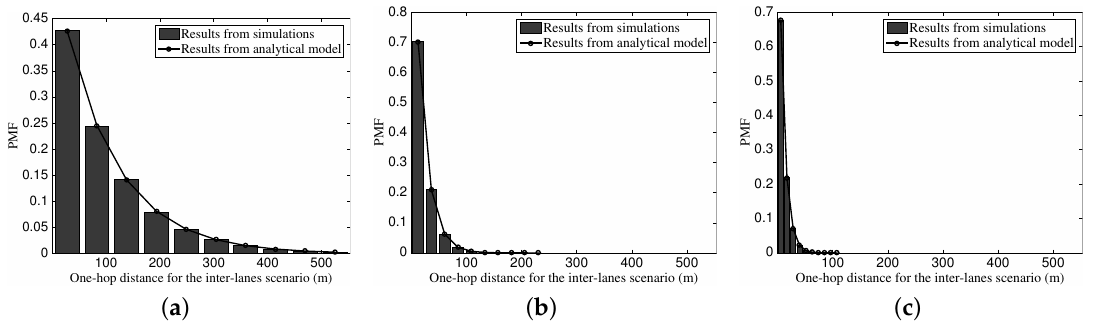
Figure 9. The PMF of one-hop transmission distance for the inter-lane scenario with different vehicular traffic density: ( a ) ρ 2 = 10 vehs/km; ( b ) ρ 2 = 50 vehs/km; ( c ) ρ 2 = 100 vehs/km.